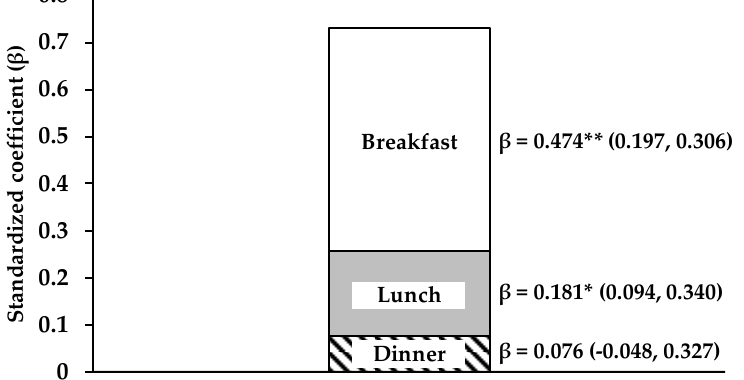
Figure 1. Contribution of achieving 0.24 g/kg BW of protein intake at each meal to total protein intake in all subjects. Multivariate regression analysis was used to examine the association of achieving 0.24 g/kg BW of protein intake at breakfast, lunch, and dinner (0: not achieved, 1: achieved, respectively) with total protein intake. Standardized coefficient ( β ) was obtained with adjustment for age, sex, drinking habit, smoking habit, living condition (alone or family), PSQI, MEQ, and IPAQ scores, and total energy intake with residual methods 7 . * : p < 0.05, ** : p < 0.001. Abbreviations: BW, Body Weight;